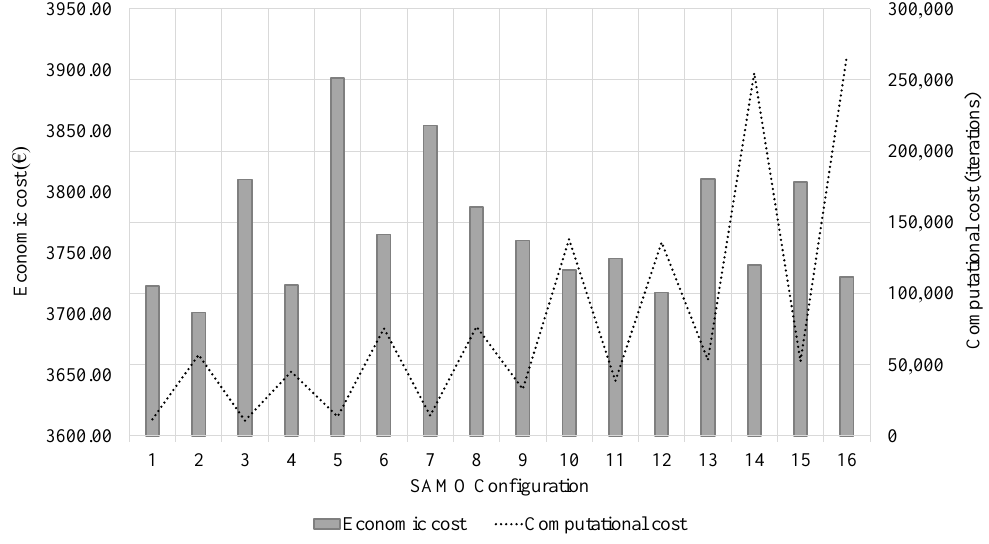
Figure 2. DoE results for the SAMO hybrid metaheuristic. Table 5. DoE mean minimum cost results and associated computational cost for each